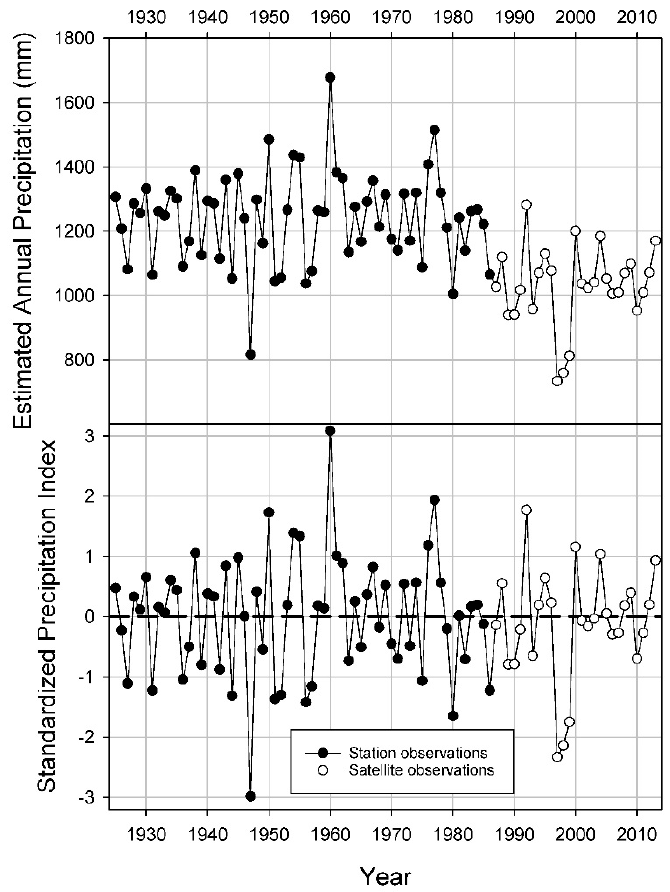
Figure 6. ( Upper ) Combined time series of inputs (mm) based on historic station records (closed symbols) and gridded data (open symbols). ( Lower ) Combined time series once the two data sets were standardized by their respective means and standard deviations.